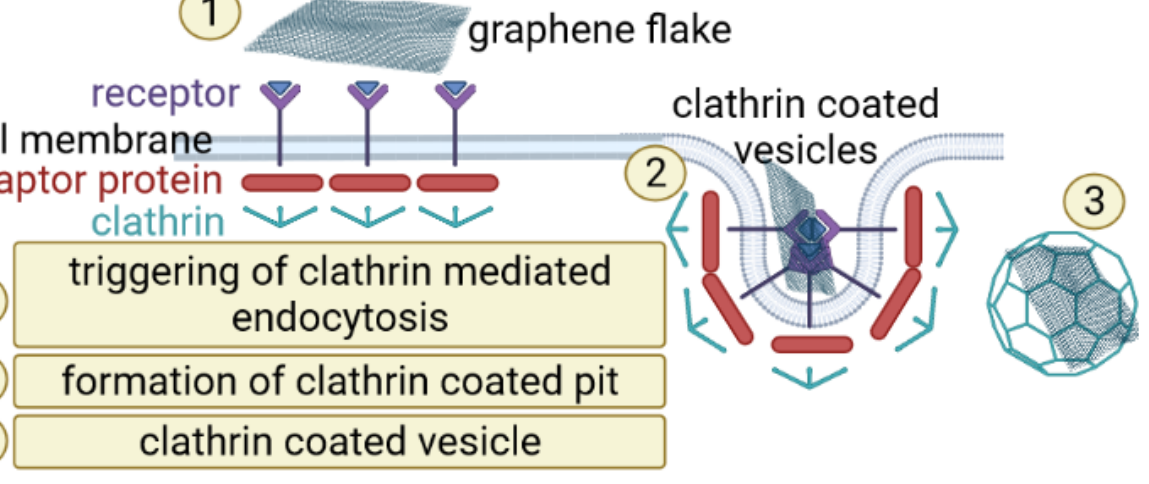
Figure 2. A scheme of clathrin-mediated graphene endocytosis. Composed with BioRender [21].